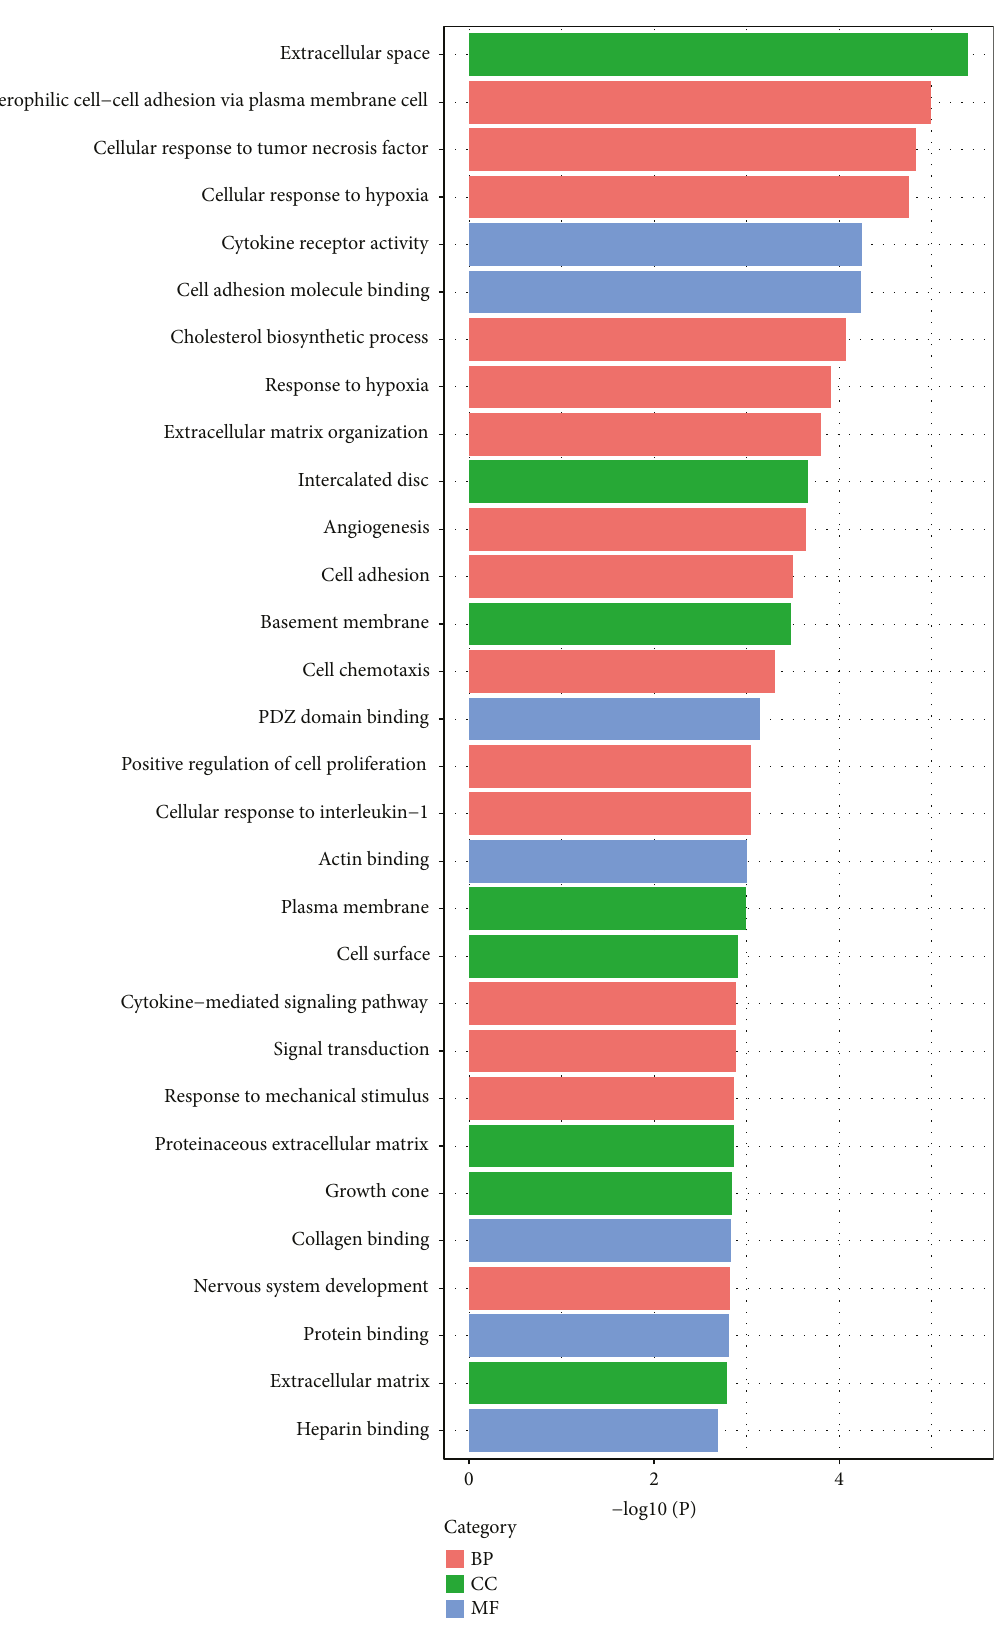
Figure 3: Top thirty signi fi cant enriched GO terms of DEGs in BC according to their functions. GO: gene ontology; BP: biological process; MF: molecular function; CC: cellular component; DEGs: di ff erentially expressed genes; BC: bladder